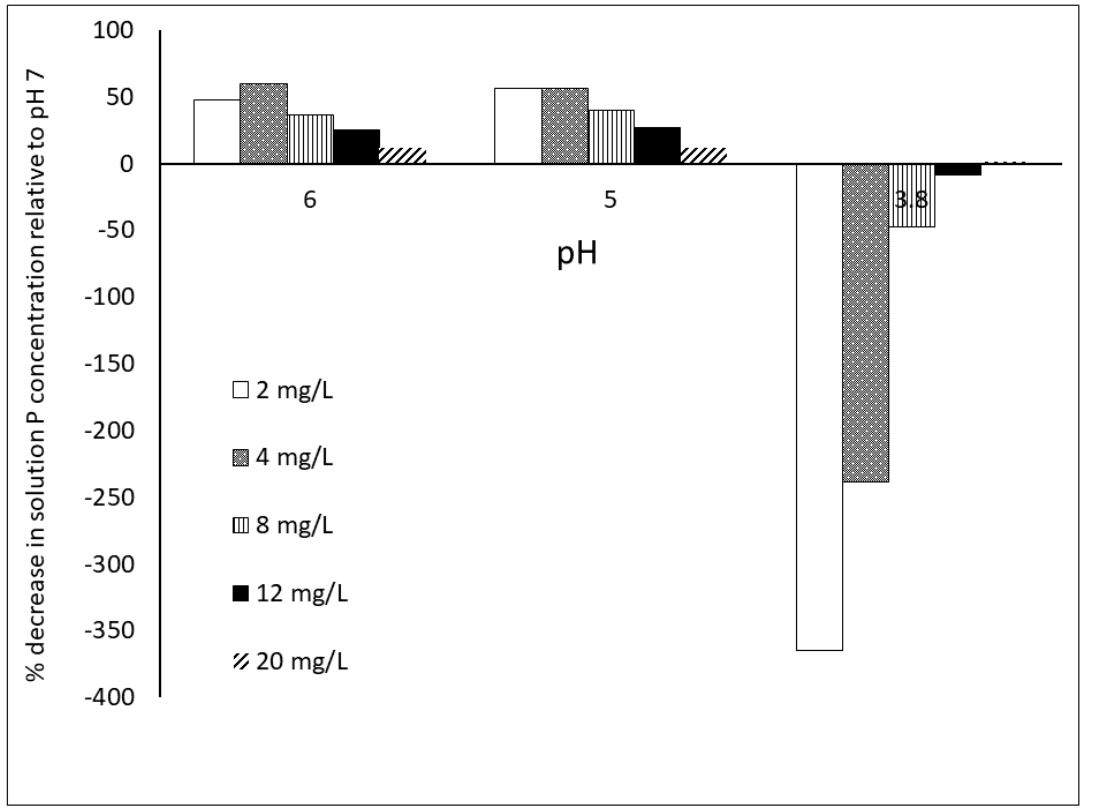
Figure 3. Percent decrease in equilibrium solution phosphorus (P) concentrations relative to pH 7 for an amorphous aluminum hydroxide mineral, shown as a function of pH (adjusted with NaOH) and P addition (2, 4, 8, 12, and 20 mg P/L). Drawn with data from Hsu and Rennie [19]. Positive values indicate a decrease in equilibrium solution P concentration compared to pH 7, within a given P addition level.